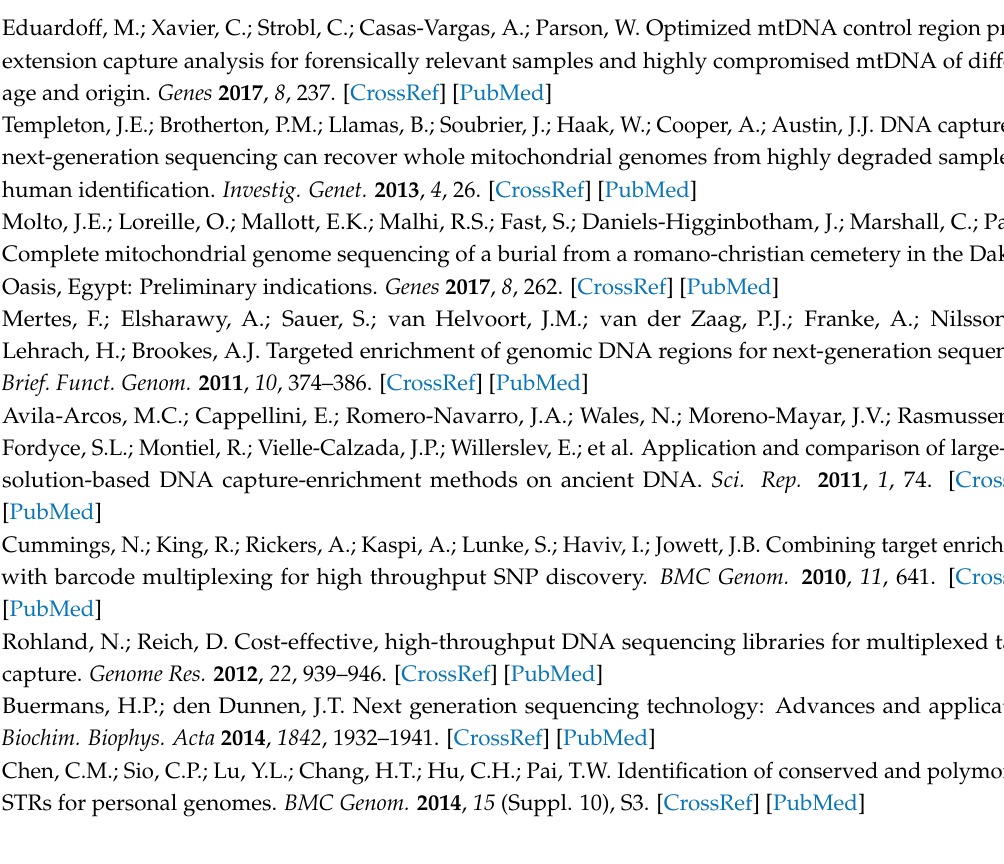
Table S1: Information Corresponding to SNP Number from Figures 3 and